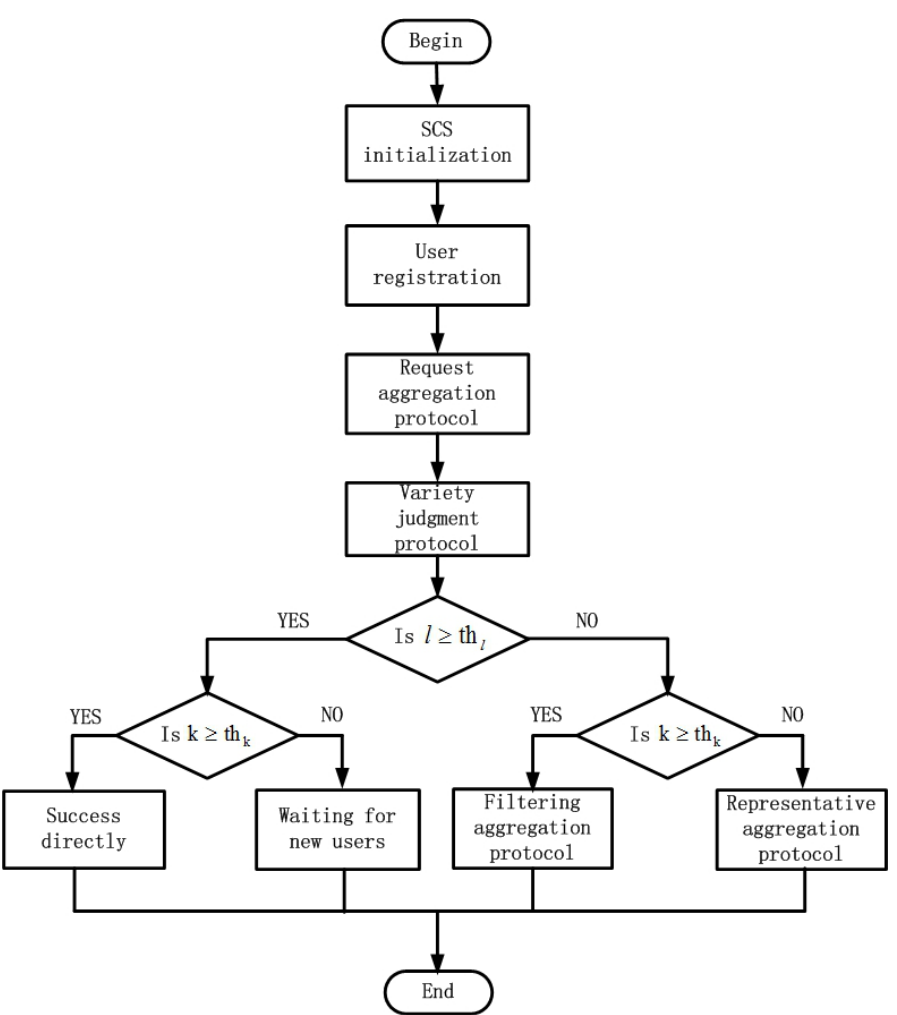
Figure 10. The scheme of service category table based algorithm